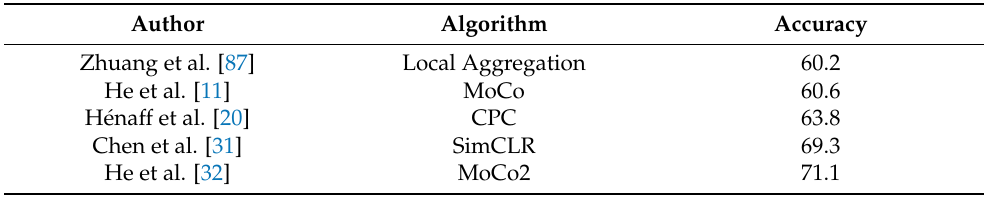
Table 4. Results of using learned feature representations from Contrastive Learning pretext tasks for the downstream task of ImageNet classification using a ResNet-50 architecture. For comparisons of results for downstream tasks with networks trained using supervised training, please refer to